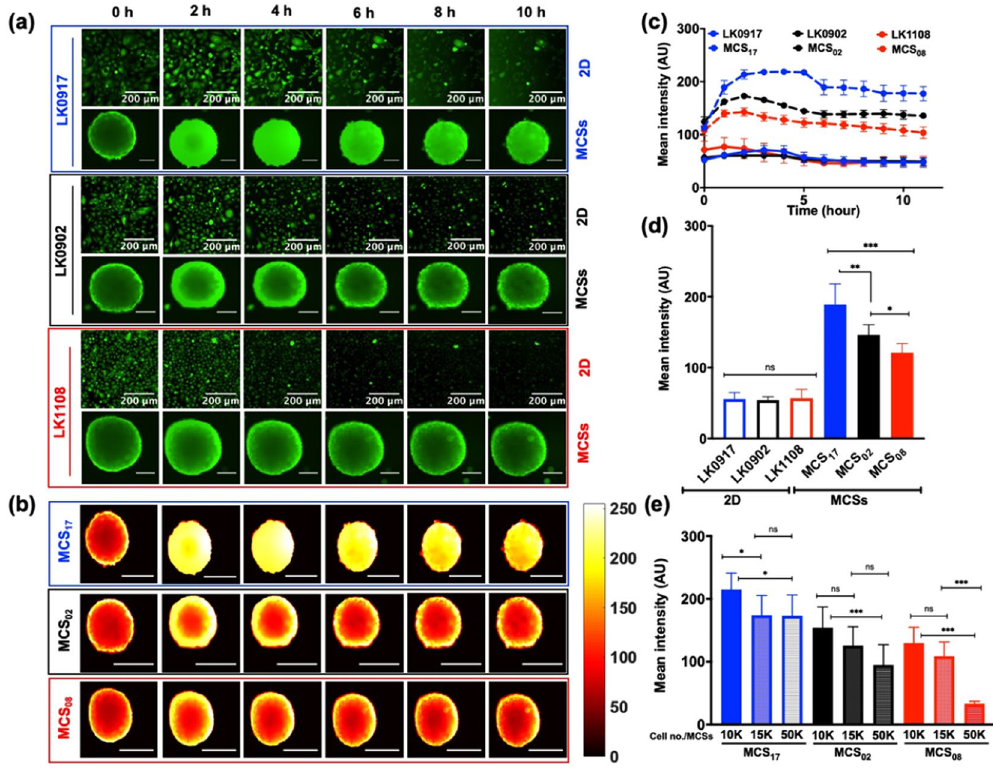
Figure 4. Real-time monitoring of calcein-AM uptake in 2D and MCSs. ( a ) Elucidate calcein-AM uptake in 2D cell cultures and MCSs obtained from LK0917- MCS 17 (upper panel), LK0902- MCS 02 (middle panel), and LK1108- MCS 08 (lower panel) and over a time span of 10 hours with image acquisition at 20-minute intervals (scale bar, 200 μ m). ( b ) Heat map pseudo color images of MCSs for differential calcein-AM uptake for the three cell lines (scale bar, 200 μ m, scale bar on the right represents the pixel intensity of green fluorescence). ( c ) Mean fluorescence intensity profile with respect to time (12 hours) in the 2D cell cultures (LK0917, LK0902, and LK1108) and MCSs (MCS 17 , MCS 02 , and MCS 08 ) respectively. ( d ) Total accumulated calcein over time (12 hours) in 2D and MCSs for all three cell lines. ( e ) Total accumulated calcein profiles of MCSs obtained from different cell densities. The data are shown as mean ± SD; *** p < 0.001, ** p < 0.05, * p = 0.019, and ns = non- significant (n =